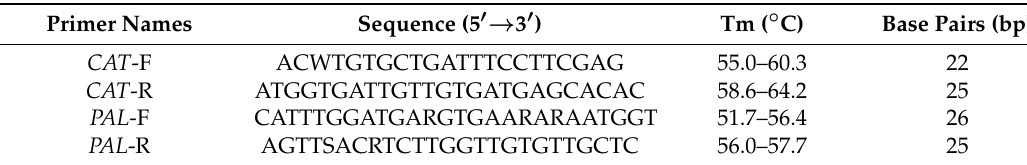
Table 1. Degenerate primers for isolation of HbCAT and HbPAL